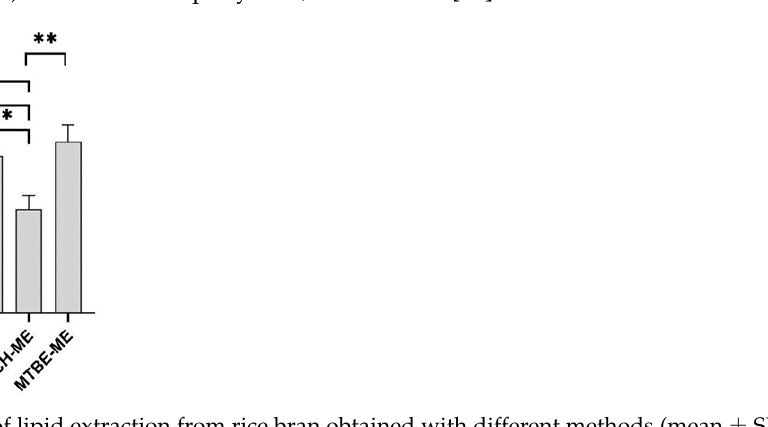
Figure 2. Yields of lipid extraction from rice bran obtained with different methods (mean ± SD of two replicates, * = p -value < 0.05, ** = p -value < 0.01).